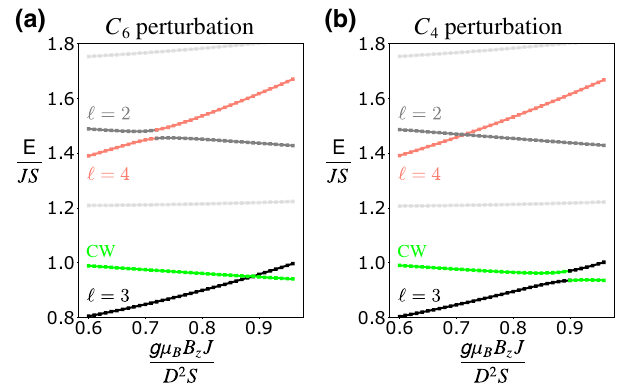
FIG. 12. Hybridization of single-skyrmion bound states under symmetry-breaking perturbations. (a),(b) Magnon spectrum of a (cid:12) + δ B and δ B z single skyrmion at k = 0 under B z + B (cid:12) z , where B z z are respectively defined in Eqs. (F1) and (F2). The continuous FIG. 11. Single-skyrmion bound states trapped inside the rotational symmetry of skyrmions is broken by (a) C 6 sym- magnetic field potential. (a) Spatial profile of magnetic field B (cid:12) metric perturbations and (b) C 4 symmetric perturbations. The z from the center of the skyrmion, added on top of uniform mag- symmetry-breaking perturbation results in hybridization between is given in Eq. (F1). The netic field B z . The expression for B (cid:12) the lowest (cid:13) = 4 mode (salmon) and second (cid:13) = 2 mode (dark z inset shows the spin configuration of a single skyrmion inside the gray) in (a), and between the lowest (cid:13) = 3 mode (black) and CW magnetic field trap, obtained at D / J = 0.5 for 50 × 50 spins with mode (lime) in periodic boundaries. (b) Spectrum of single-skyrmion bound states at k = 0 as a function of uniform magnetic field B z . High- lighted modes are CCW (cyan), breathing (magenta), CW (lime), (cid:13) = 2 (blue), (cid:13) = 3 (black), (cid:13) = 4 (salmon), (cid:13) = 5 (orange), (cid:13) = 6 (green), and (cid:13) = 7 (purple). (c) Wave function of high-energy skyrmion bound states obtained at g μ B B z J /( D 2 S ) = 0.65. From left to right, we show second-order CCW, second-order breath- ing modes, (cid:13) = 6, and (cid:13) = 7. Their eigenenergies are E /( JS ) = 1.21, 1.92, 2.84, and 3.58. The color code is the same as in Figs. 7(c)–7(g).